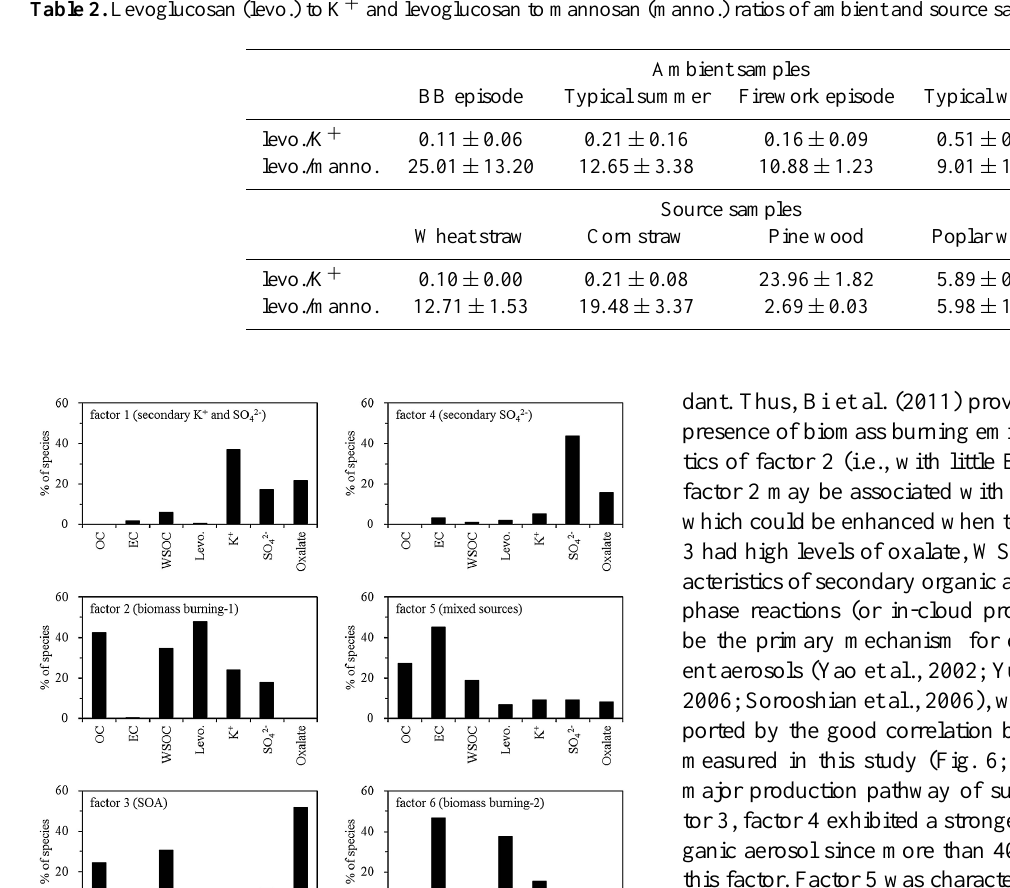
Table 2. Levoglucosan (levo.) to K + and levoglucosan to mannosan (manno.) ratios of ambient and source samples.